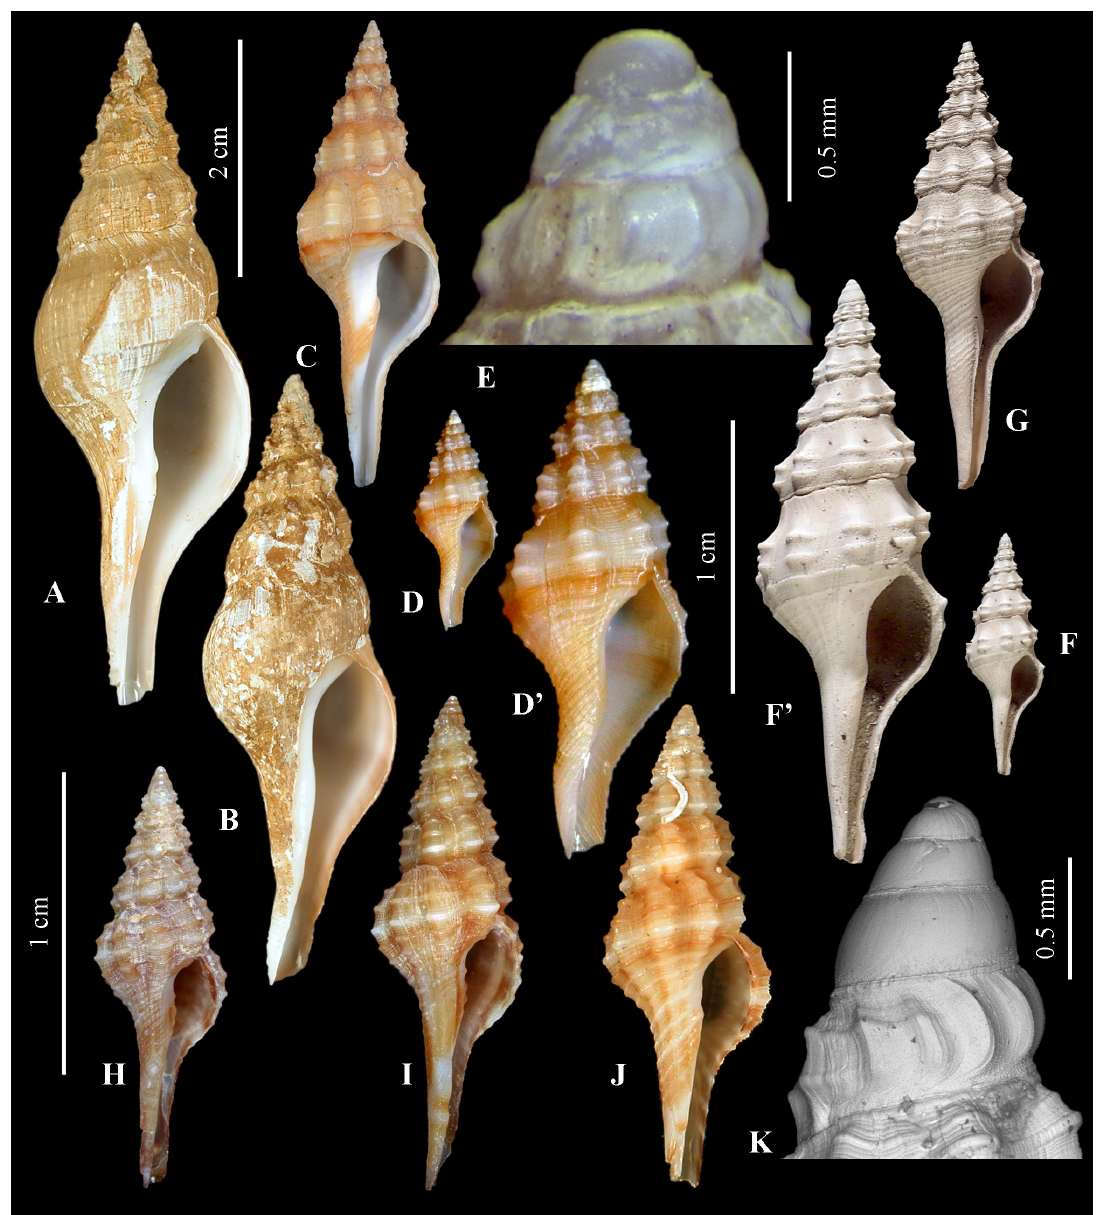
Fig. 3. A–E . Granulifusus discrepans (Kuroda & Habe, 1961). A . Philippines, SL 58 mm, sequenced specimen (MNHN IM-2007-34581). B . Philippines, SL 51.9 mm, sequenced specimen (MNHN